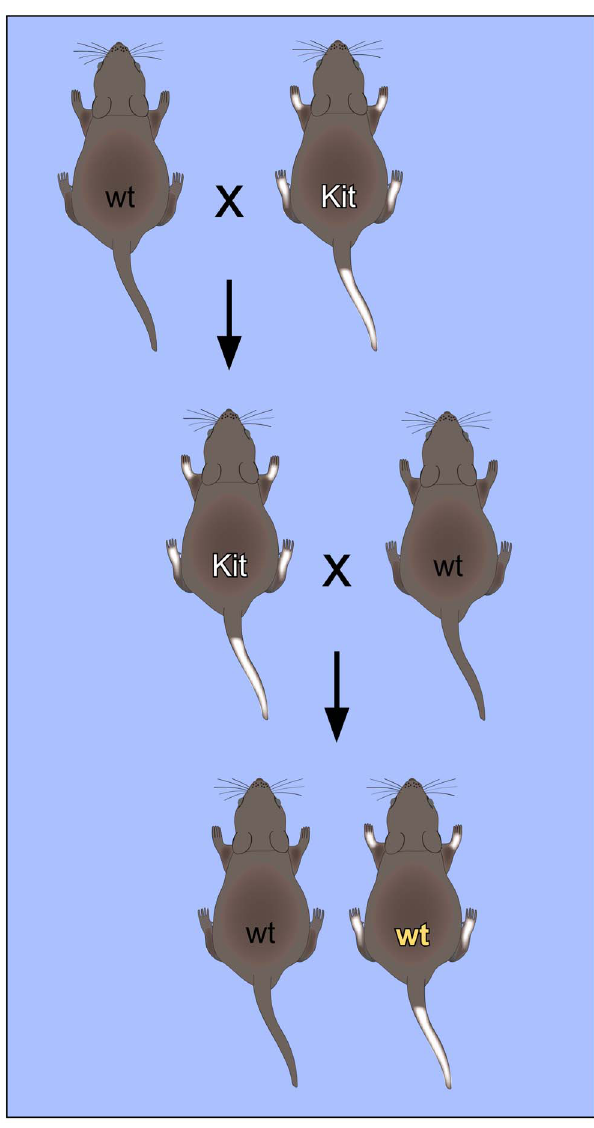
Figure 1. Non-Mendelian inheritance of mouse paramutations. The ‘‘white-spotted’’ Kit tm1Alf/ + mouse phenotype provides an impor- tant paradigm for RNA-mediated non-Mendelian inheritance. Mating of heterozygous Kit tm1Alf/ + (Kit) mice with wild-type (wt) mice results in Kit tm1Alf/ + (Kit) offspring with characteristic white tails and feet. When these mice are again mated with wild-type mice, a fraction of the offspring retains the ‘‘white-spotted’’ phenotype, even with a wild-type genotype. This phenotype could also be induced by microinjection of RNA into fertilized oocytes, which suggests that RNA plays an important role in the mechanism of